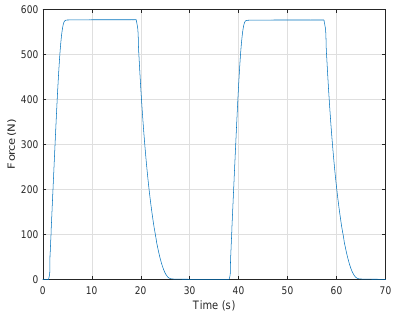
Figure 18: 2-axis trunnion: two force application cy-